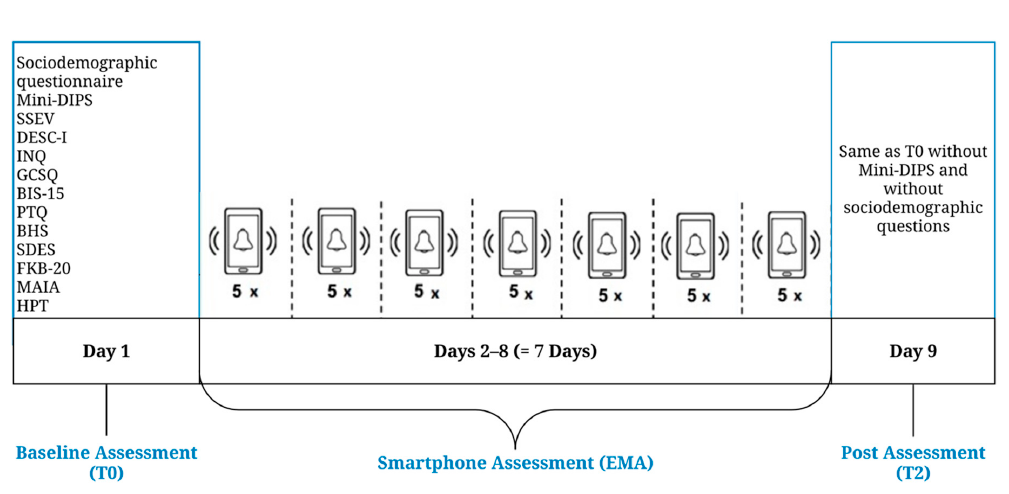
Figure 2. Study design. Mini-DIPS = structured clinical interview for diagnosing mental